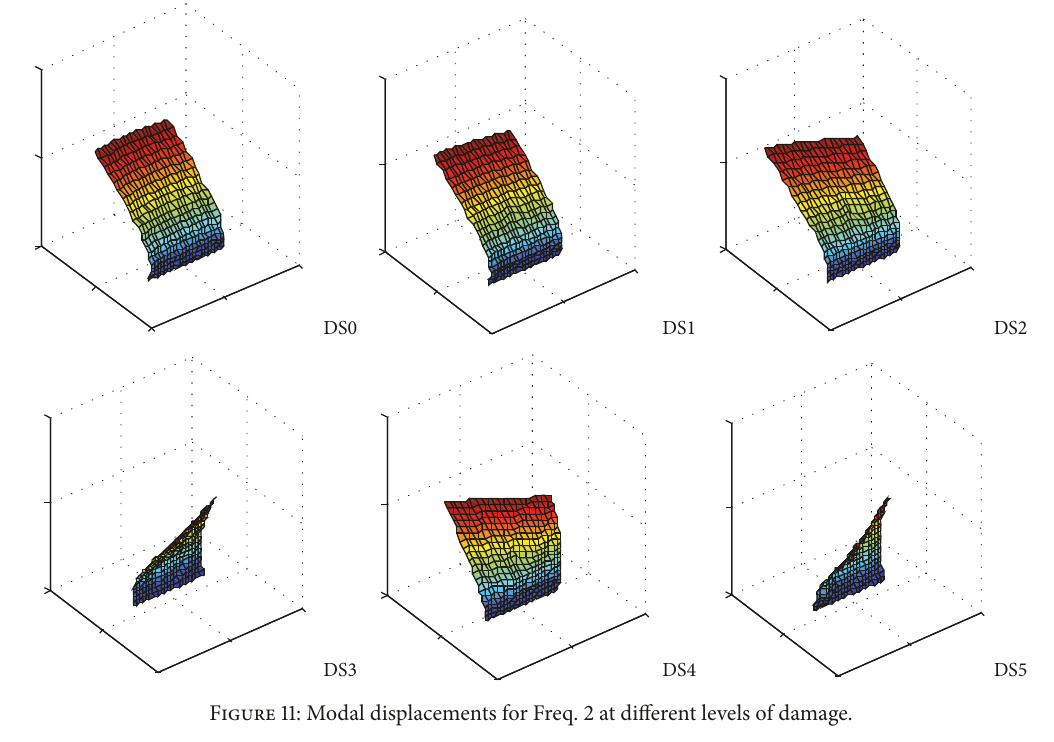
Figure 11: Modal displacements for Freq. 2 at different levels of damage.